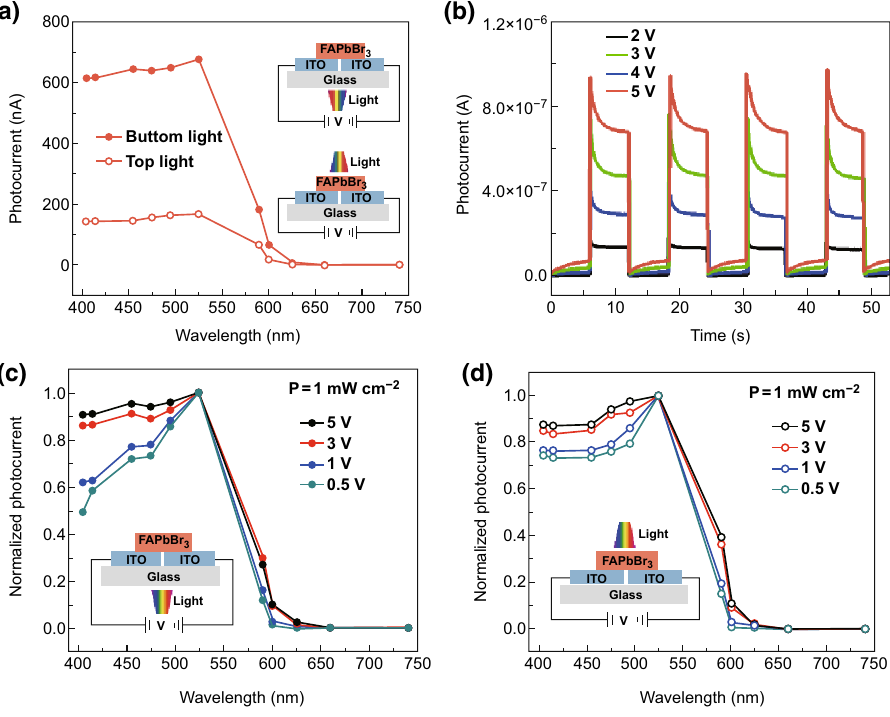
Fig. 3 a Spectral-dependent photocurrent under front-side and back-side excitation at 1 mW cm - 2 and a bias voltage of 5 V. b Photocurrent response measured using a series of bias voltages: 2, 3, 4, and 5 V, at an excitation of 495 nm. Normalized spectral-dependent photocurrent under different bias voltages under c back-side and d front-side